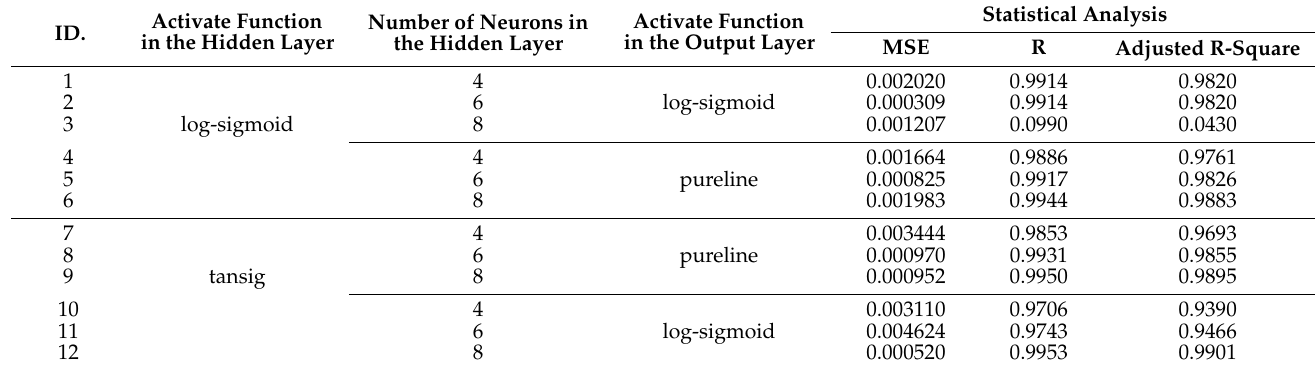
Table 2. ANN architectures